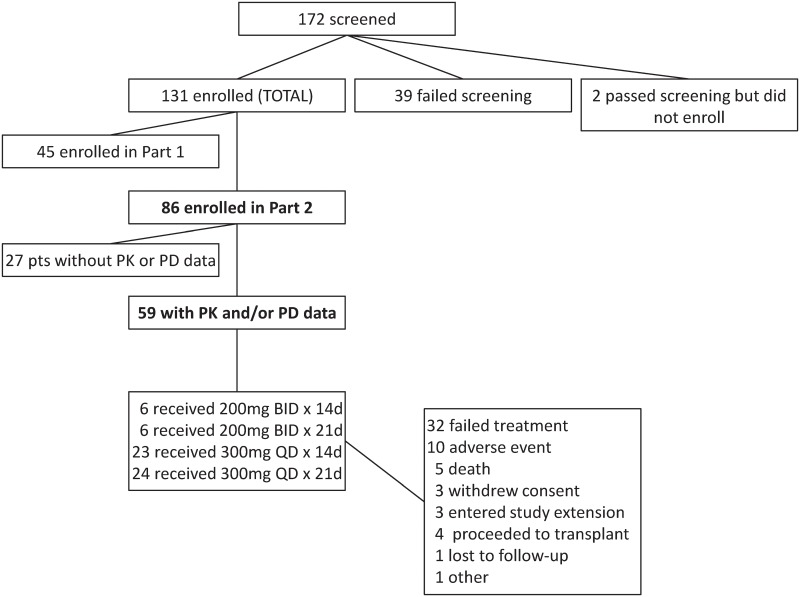
Study flow-chart.